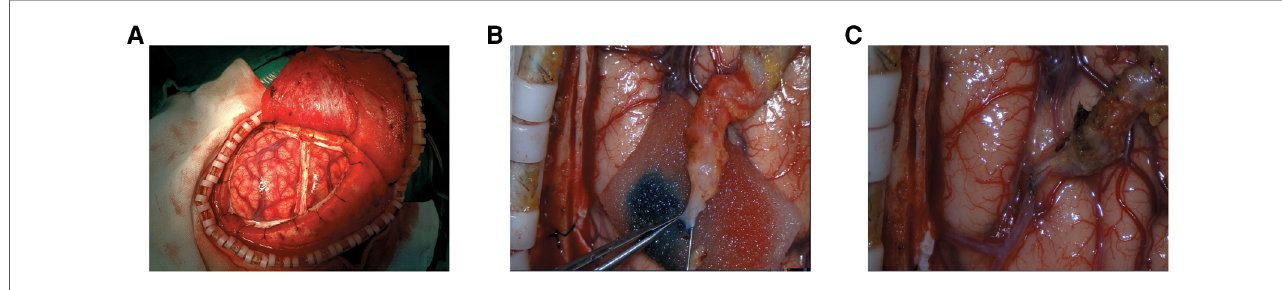
FIGURE 1 The surgical revascularization procedures. ( A ) The temporal muscle covered by its fascia was incised along the parietal branch; ( B ) The more prominent branch of STA was chosen for the direct anastomosis; ( C ) The STA was fi sh-mouthed and sutured to a cortical M4 MCA branch with continuous 10-0